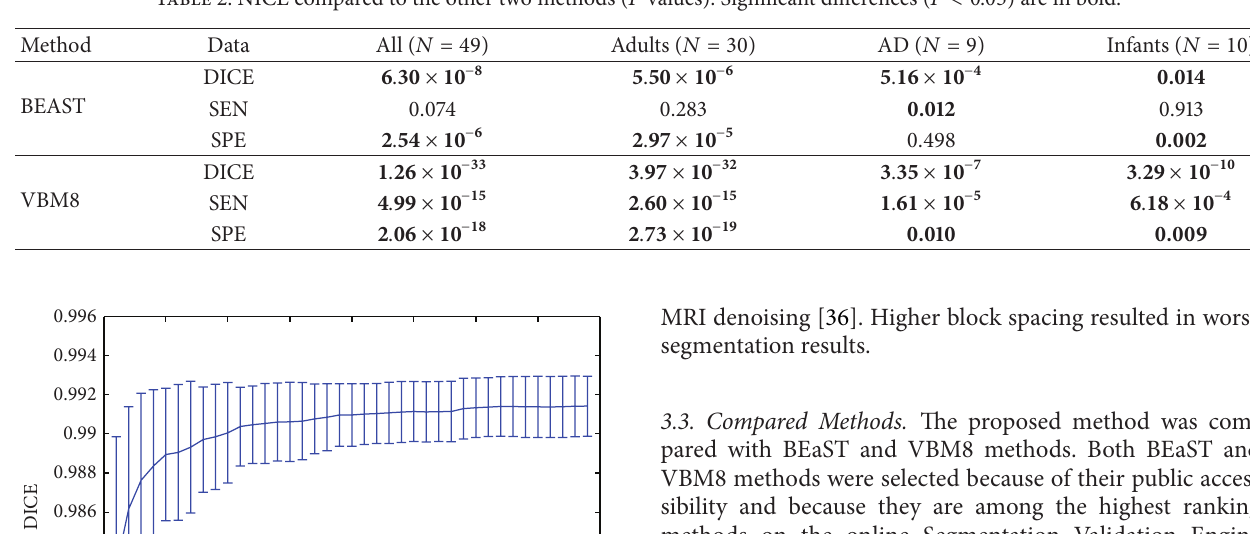
Table 2: NICE compared to the other two methods ( 𝑃 values). Significant differences ( 𝑃 < 0.05 ) are in bold.